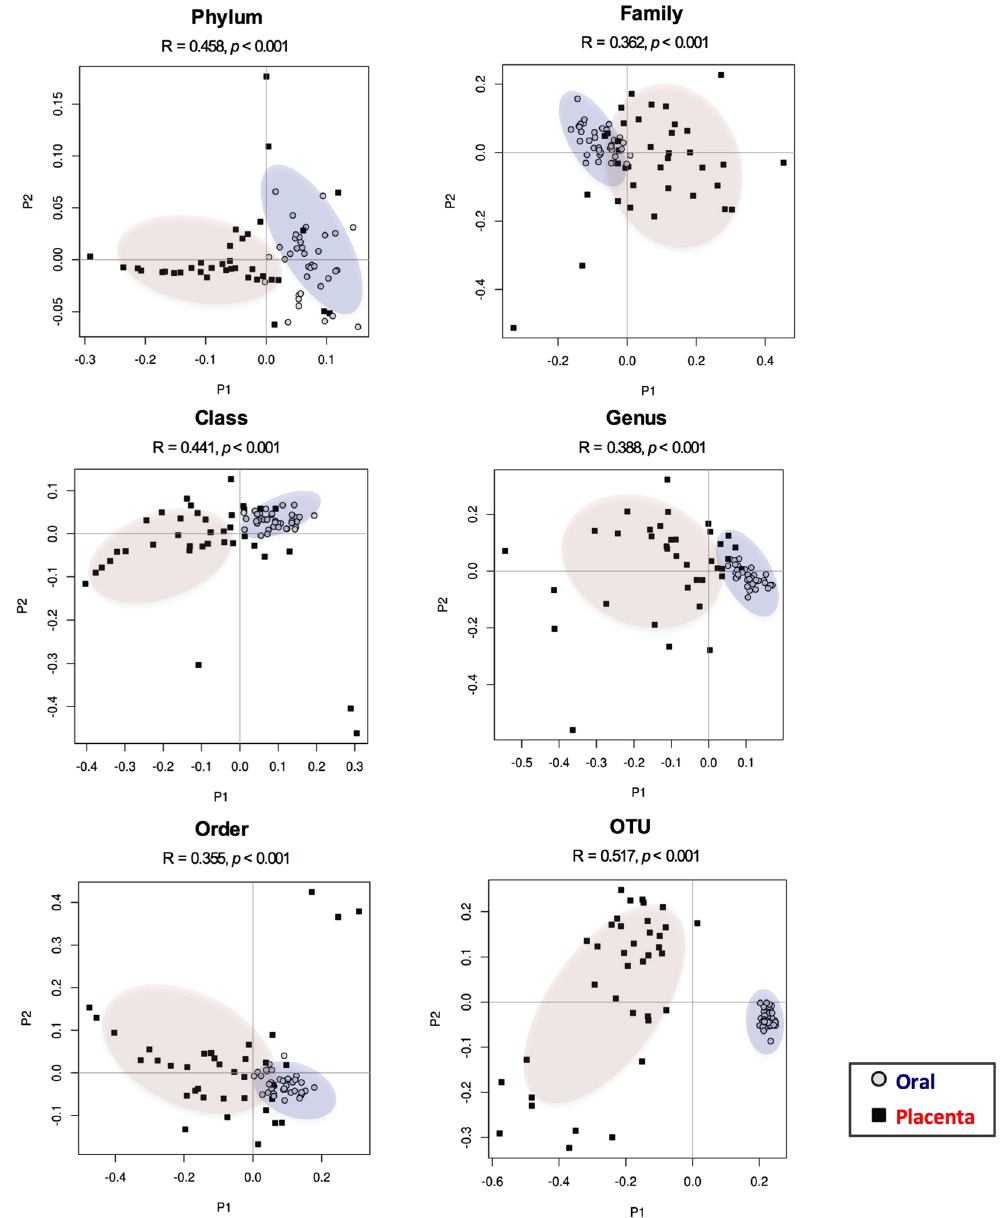
Figure 2. Differences in microbiome composition among the placental and maternal oral populations. PCoA plots for placental (red) and maternal oral (blue) microbiome at different taxonomic levels. Differences in microbial composition between the placenta and oral samples were determined by Anosim statistic test. An R value close to 1.0 indicates total dissimilarity between the two groups. Significant differences between the placental and oral microbiome were reported at all taxa levels (p <